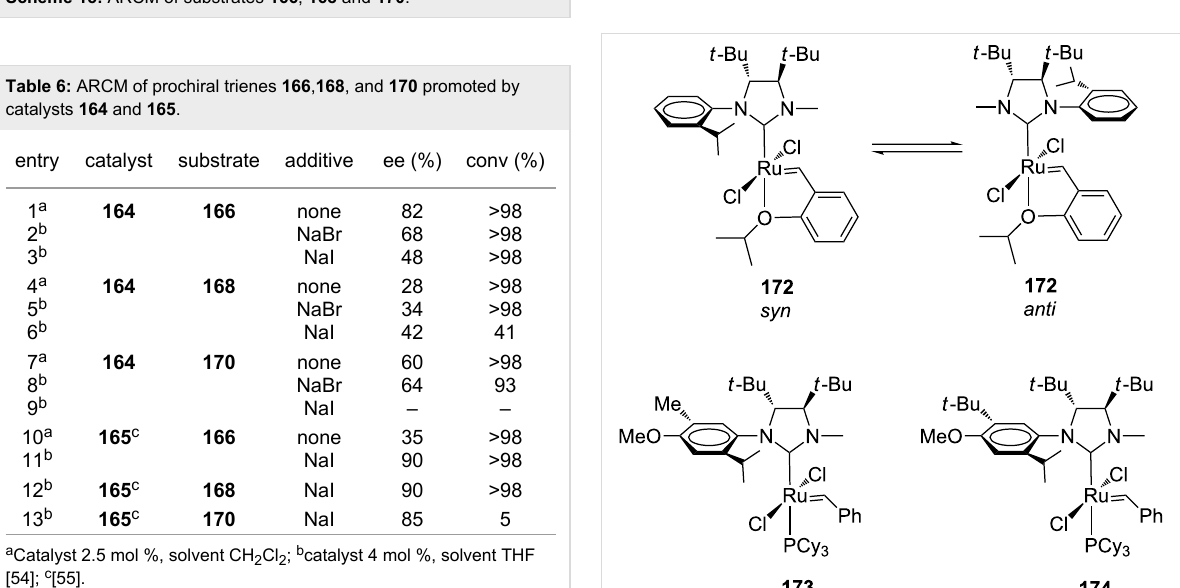
Scheme 15: ARCM of substrates 166 , 168 and 170 .